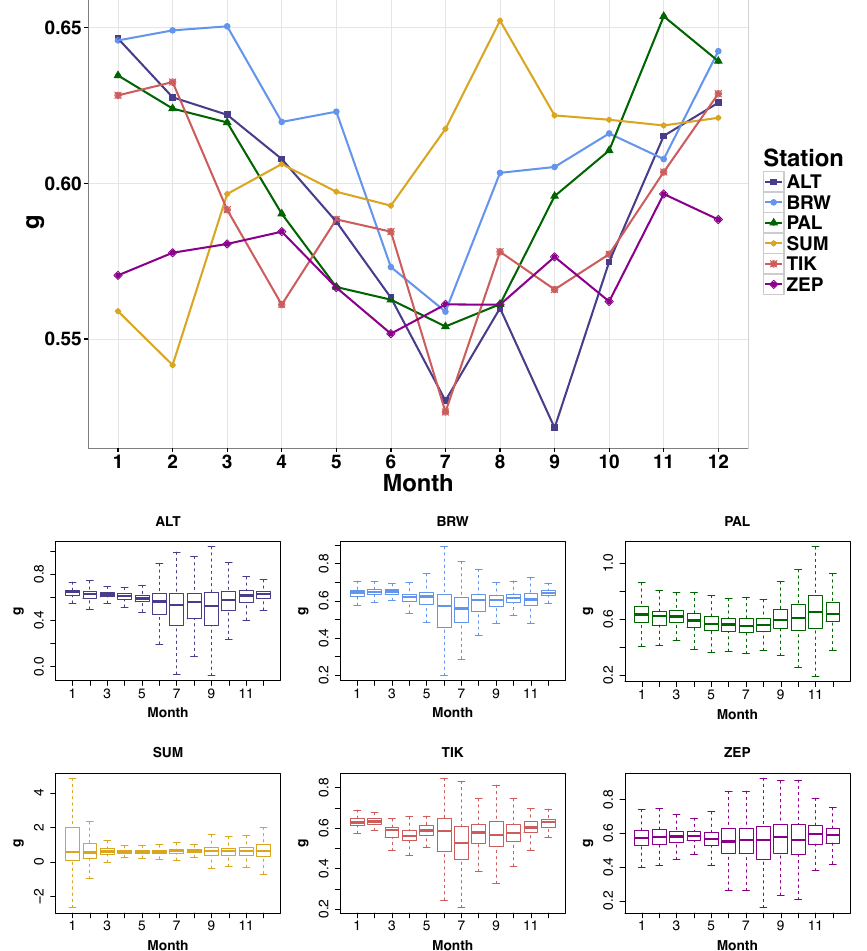
Figure 7. Seasonality of aerosol asymmetry parameter (g) at all sites. Large plot shows monthly medians of hourly average g at 550nm at each station, subplots below show boxplots of g at individual sites with horizontal line at the median, edges of the box at 25 th and 75 th percentiles, and whiskers at 5 th and 95 th percentiles. Note that y-axes are difference on each plot.